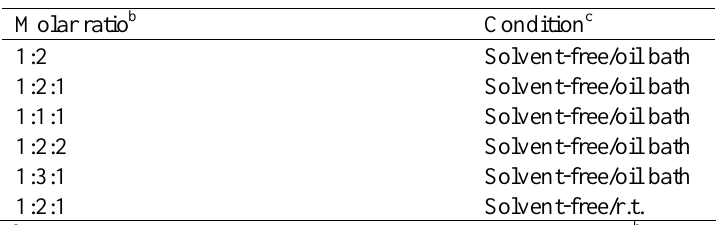
Table 1. Optimization Experiments for Oximation of Benzaldehyde with NH OH•HCl/SiO @FeSO Nano Composite System 2 2 4